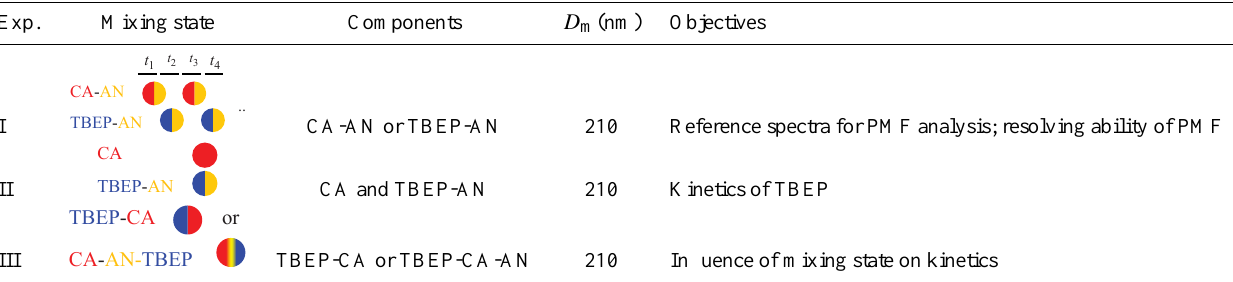
Table 1. Experimental details for oxidation.